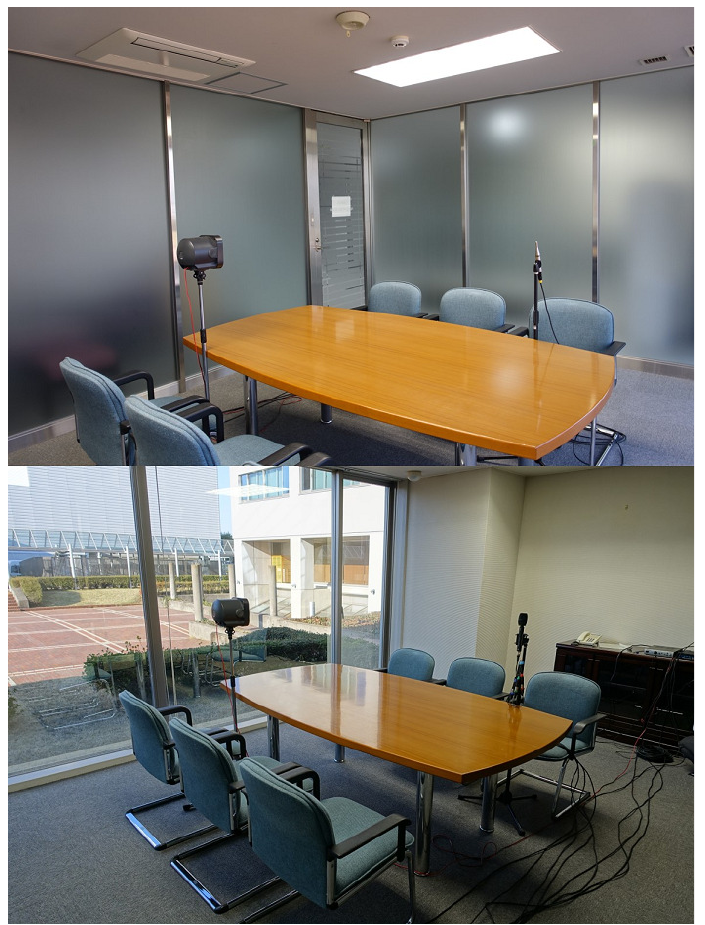
Figure 7. Interior views of the small meeting room measured for this